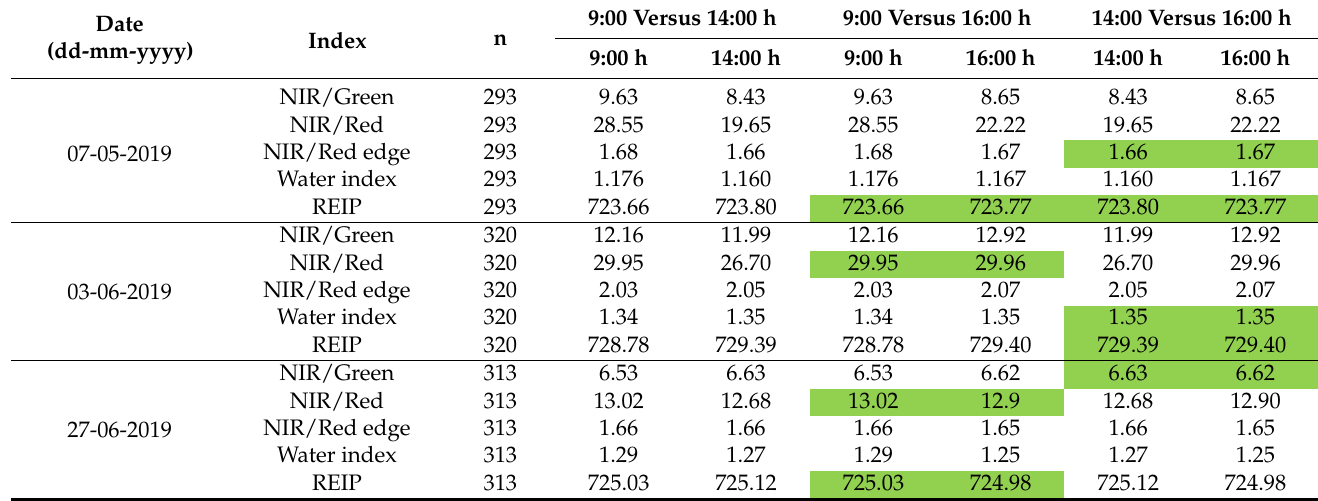
Table 6. Mean values of each vegetation index for paired measurement times (9:00 versus 14:00 h, 9:00 versus 16:00 h, and 14:00 versus 16:00 h) measured with the vehicle-carried hyperspectral bidirectional passive spectrometer on each date of measurement. Green shading indicates non-significant differences between paired measurement times using t -Tests; all other pairs were statistically different ( p < 0.016, corrected by Bonferroni for multiple comparisons).